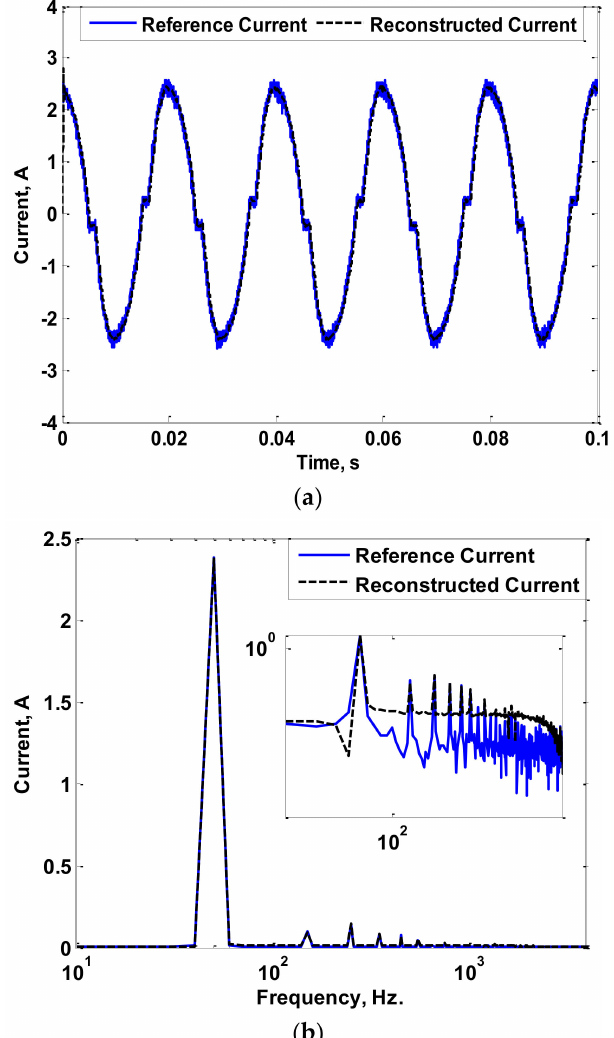
Figure 13. Reference and Reconstructed Currents of a 300 W luminaire: ( a ) Reference and Recon- structed Current Waveforms; ( b ) FFT of Reference and Reconstructed Currents.